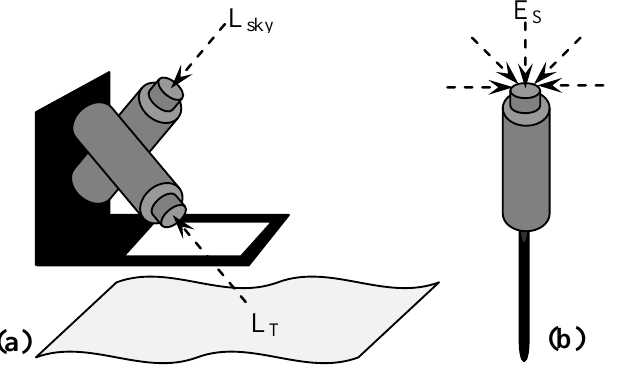
Figure 3. Radiometers used to acquire in situ field spectra above water from the boat. The HyperSAS L and L sensors (a) were mounted on a frame on a tripod viewing over the sky T side of the boat and the E cosine collector (b) was mounted vertically on a 2 m dowel at S the highest point on the